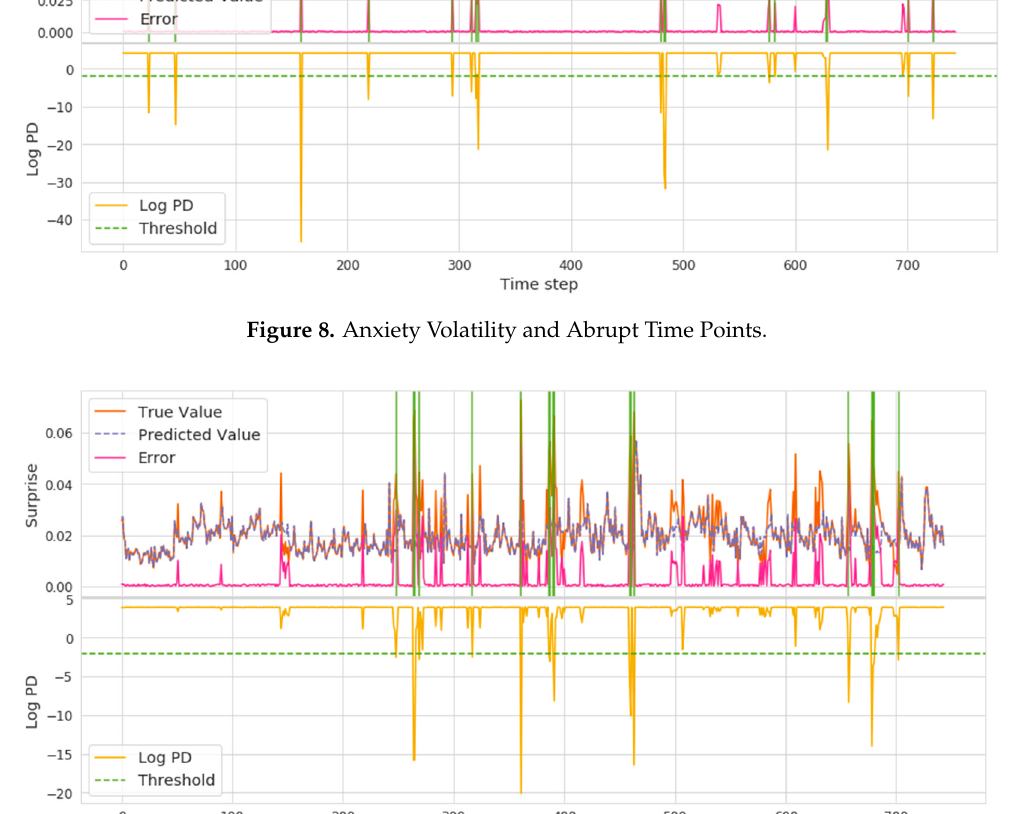
Figure 8. Anxiety Volatility and Abrupt Time Points.